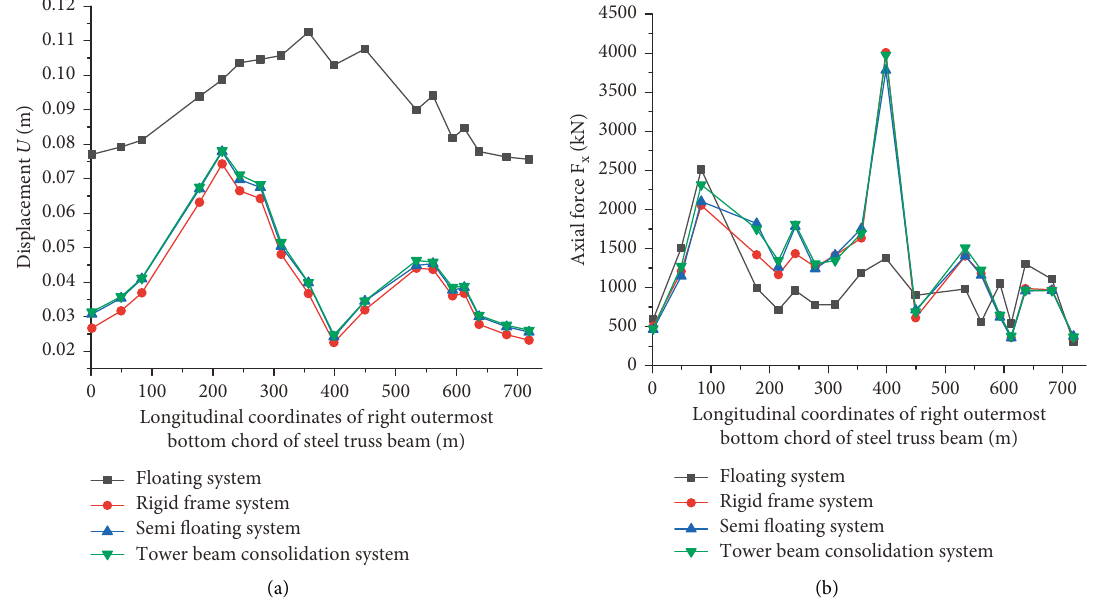
Figure 11: Longitudinal distribution of maximum chord displacement U and maximum axial force Fx of bridges with different structural systems under earthquake action. (a) Longitudinal distribution of the maximum value of the displacement and (b) longitudinal distribution of the maximum value of the axial